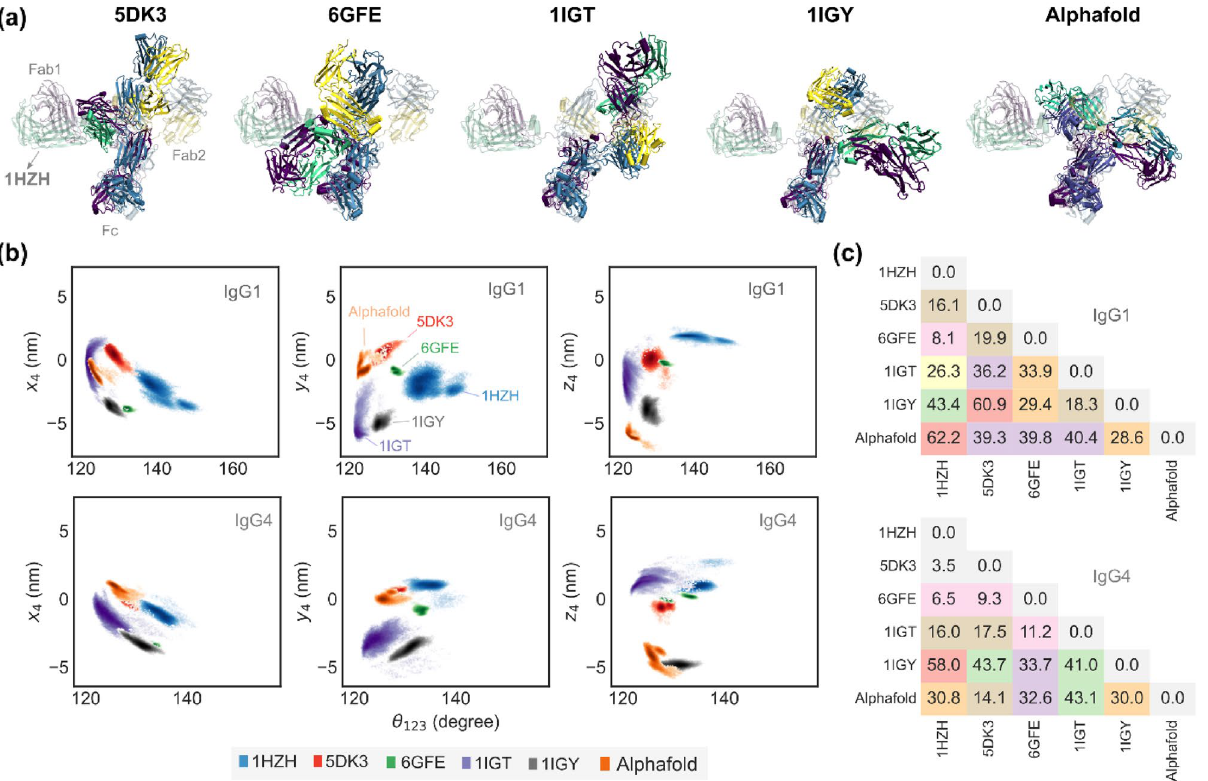
Figure 3. ( a ) Snapshots of IgG1 molecules generated by homology modeling of 1HZH, 5DK3, 6GFE, 1IGT, 1IGY crystal structures, all aligned to the Fc region of 1HZH. The reference 1HZH structure is shown in the background for comparison. The conformation of the AlphaFold structure post 1000 ns of relaxation is also shown. ( b ) Spatial occupancy density plots for each structure, computed from two independent 500 ns trajectories, show x 4 , y 4 , and z 4 , the x, y, and z positions of bead 4, vs θ 123 . The point clouds associated with each group was constructed from around 5e4 observations. The conformational states accessed by each of the structures show minimal overlap in Cartesian space, pointing to the presence of locally minimum states in both IgG1 and IgG4 structures. ( c ) The spatial separation between the conformational states accessed by the various structures is quantified by the Kantorovich–Wasserstein distance metric, d KW . For reference, d KW = 0 for two identical clouds of points, and d KW = 2.6 for two normally distributed clouds of points centered around (0,0,0) and (2,0,0),